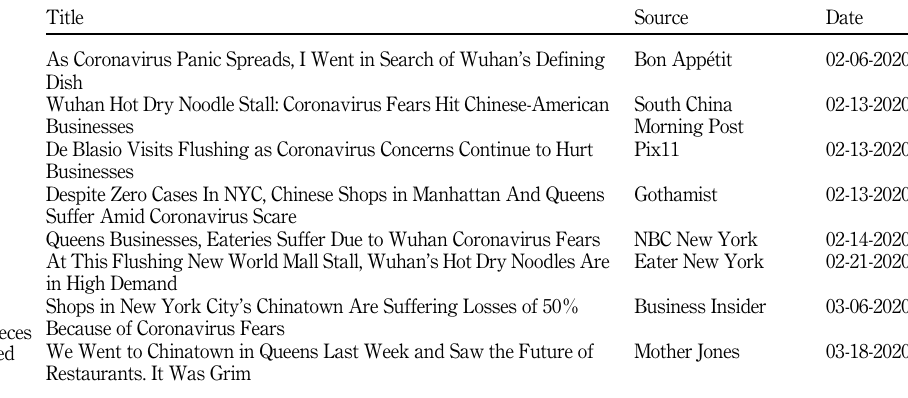
Table 1. Alistoftheeightpieces of news articles used in